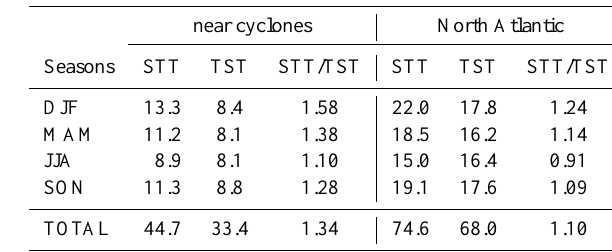
Table 1. Total mass (10 17 kg) per season from 1979 to 2011 for STT and TST in the vicinity of cyclones over the North Atlantic and the total mass over the entire North Atlantic as well as the ratio between STT and TST. The minimum lifetime of a cyclone is 1day.